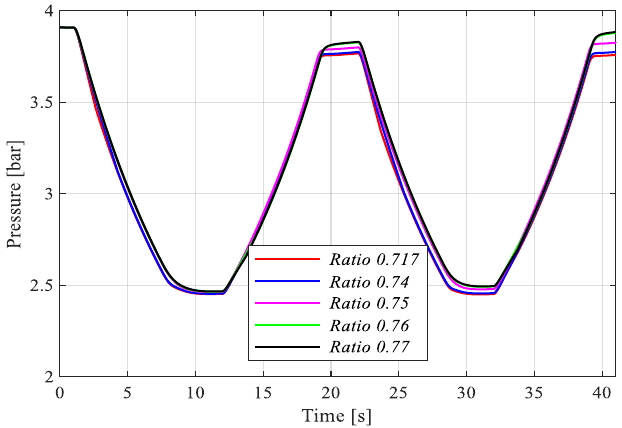
Figure 15. Pressure in the accumulator chamber for different ratios. Cracking pressure = 30 bar.